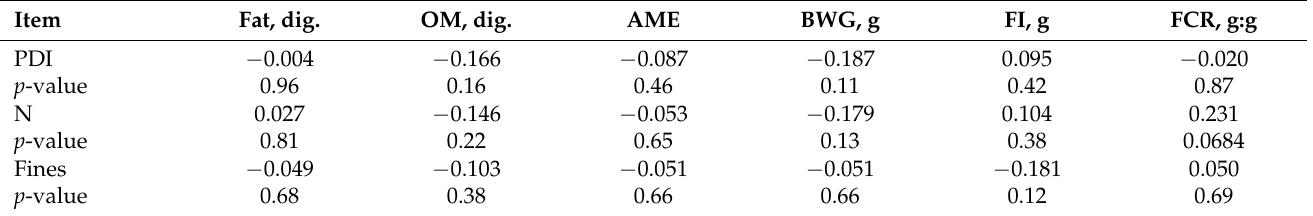
Table 15. Pearson’s correlations between feed physical proprieties and digestible and performance values of broilers in finisher feed phase, 29 to 35 d.